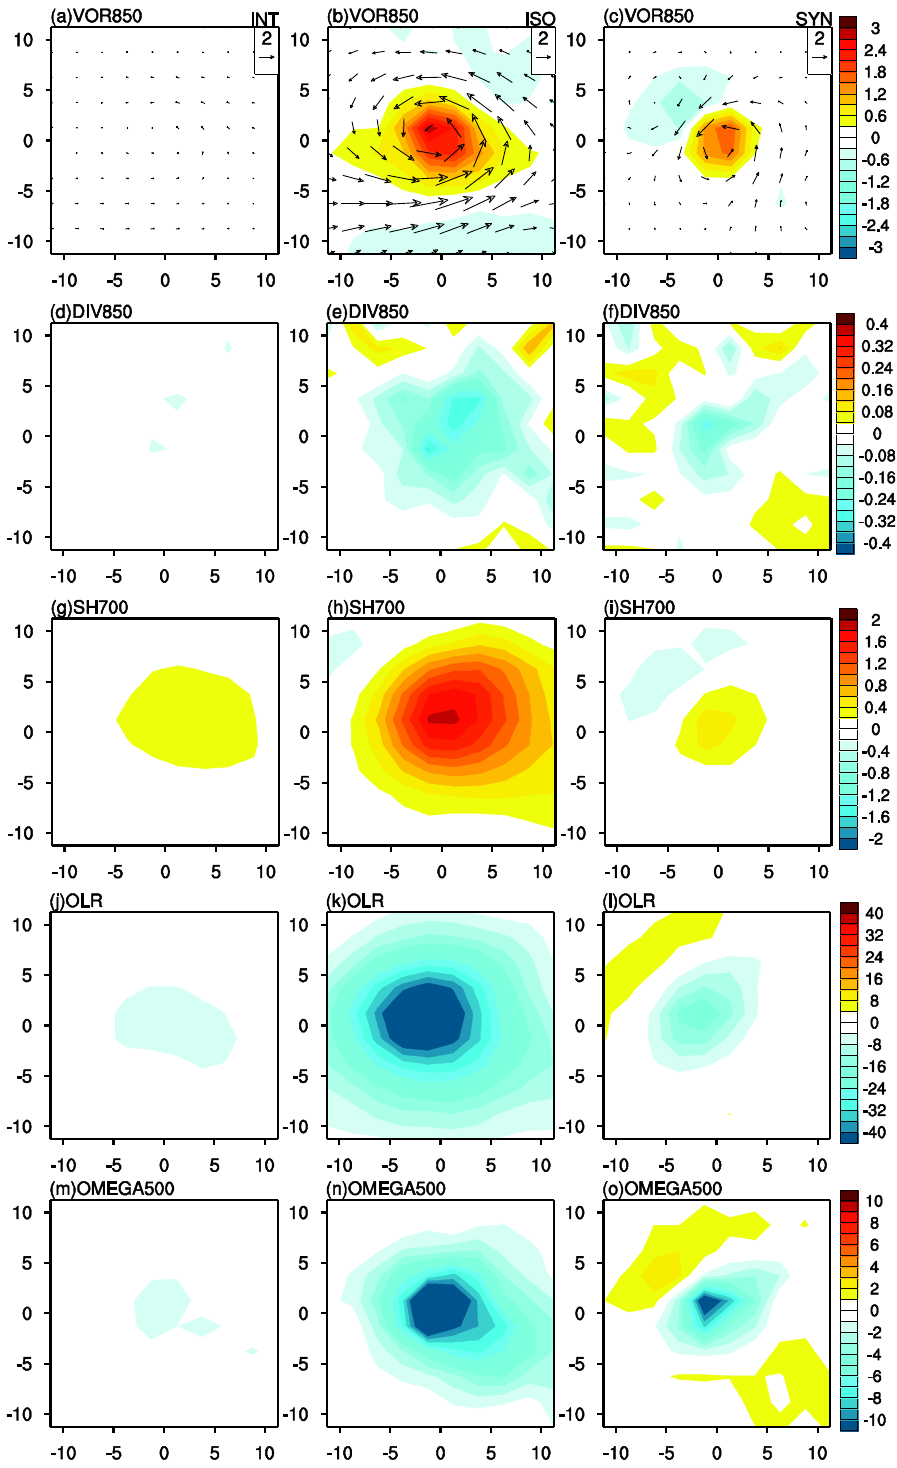
Figure 4. Composite of ( a – c ) 850 hPa wind (vector, m/s, scale at the top right) and relative vorticity (shading, 10 − 5 s − 1 ), ( d–f ) 850 hPa divergence (shading, 10 − 5 s − 1 ), ( g – i ) 700 hPa specific humidity (shad- ing, g kg − 1 ), ( j – l ) OLR (shading, W m − 2 ), and ( m – o ) 500 hPa vertical p-velocity (shading, 10 − 2 Pa s − 1 ) centered over the locations of TC formation on (left) interannual, (middle) intraseasonal, and (right) synoptic time scales during AMJJASOND from 1979 to 2020. The zero indicates the grid point nearest to the TC formation locations. The x-axis (y-axis) represents the distance ( ◦ ) from the TC center with positive distance to the east (north) and negative distance to the west